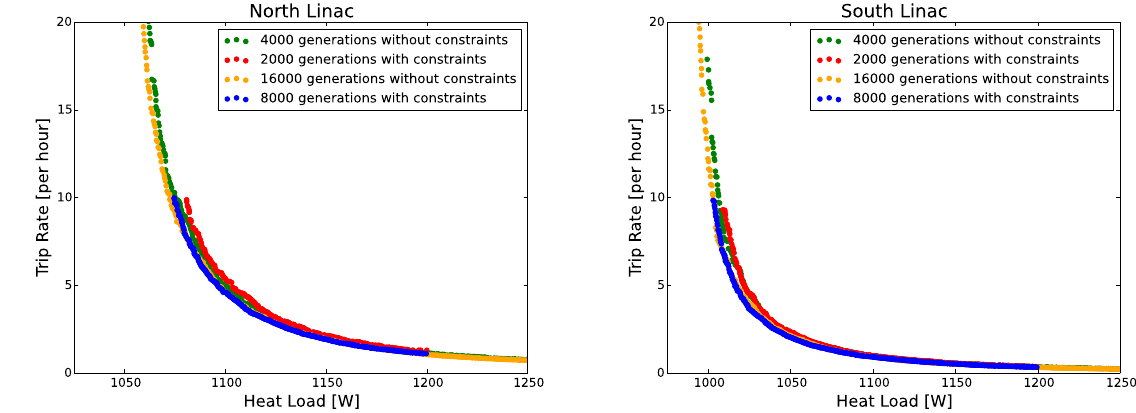
FIG. 3. Effect on the quality of the Pareto-optimal front of constraining the objective functions as in Eq. (9). Both North linac (left panel) and South linac (right panel) are constrained by T